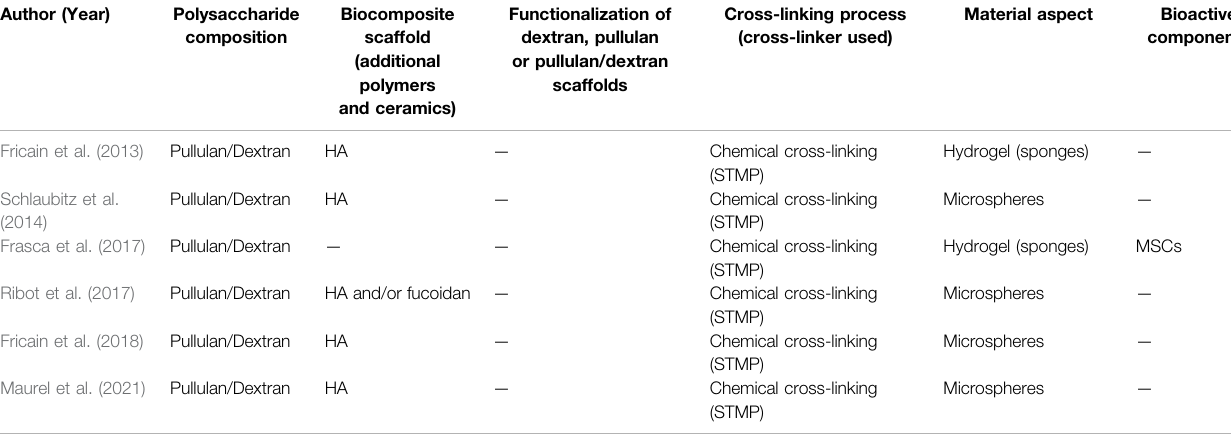
( Table 1 ). A fl owchart of the selection and inclusion process, based on PRISMA recommendations is presented in Figure 1